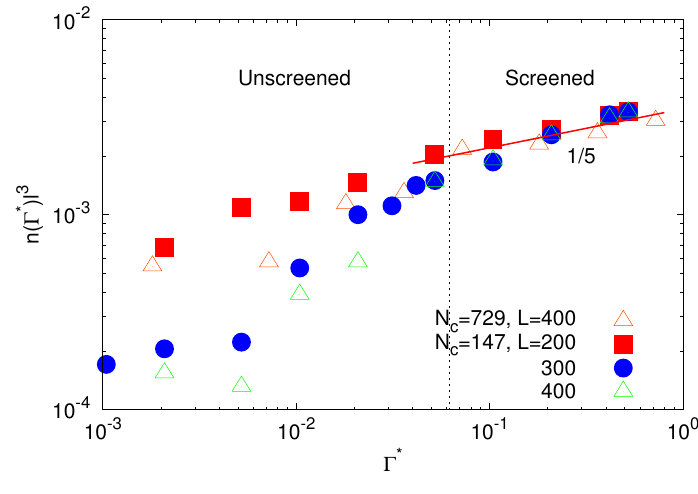
Figure 3. Density of counterions inside a microgel as a function of the scaled interaction strength for microgels with N c = 147 and 729 crosslinks. For the larger microgel, the size of the simulation box is L / l = 400, and for the smaller one with N c = 147, the boxes are L / l = 200, 300 and 400.